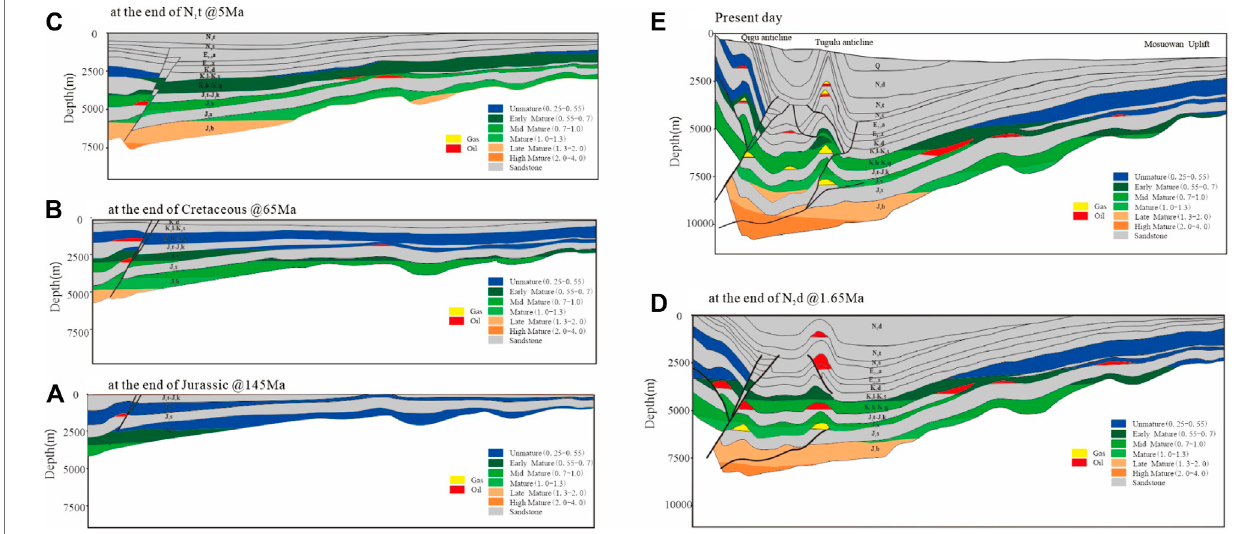
FIGURE 15 | Schematic diagram of tectonic deformation, source rock maturation, and hydrocarbon accumulation history in the middle segement of the South Junggarforelandbasin.Thestructuralandstratigraphymodelissimpli fi edfrom Figure3 . (A) Thestructure,sourcerockmaturationandHCaccumulationsituationatthe end of Jurassic at 145 Ma. (B) The structure, source rock maturation and HC accumulation situation at the end of Cretaceous at 65 Ma. (C) The structure, source rock maturationandHCaccumulationsituationattheendofN1tsedimentationat5Ma. (D) Thestructure,sourcerockmaturationandHCaccumulationsituationatthe end of N2d sedimentation at 1.65 Ma. (E) The structure, source rock maturation and HC accumulation situation at present day.